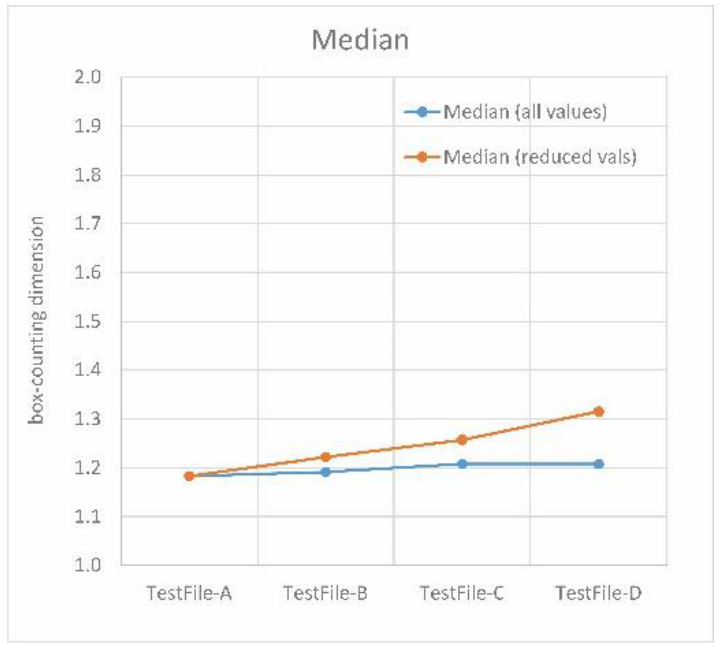
Figure 10. Results of measurement of the test cases.